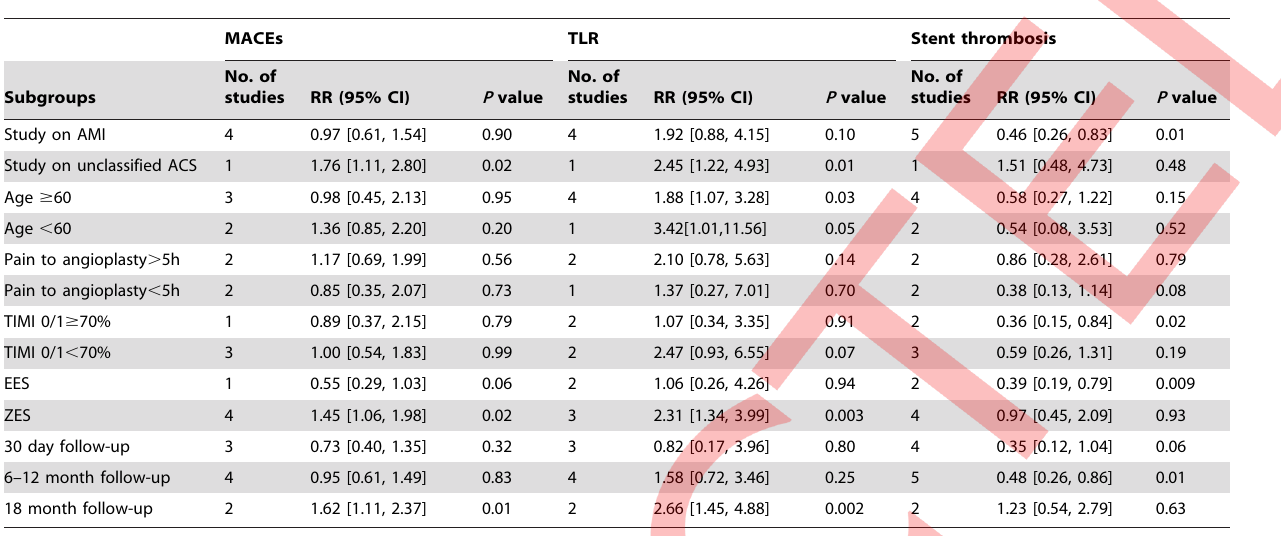
Table 3. Subgroup analyses based on the data on MACEs, TLR, and stent thrombosis.